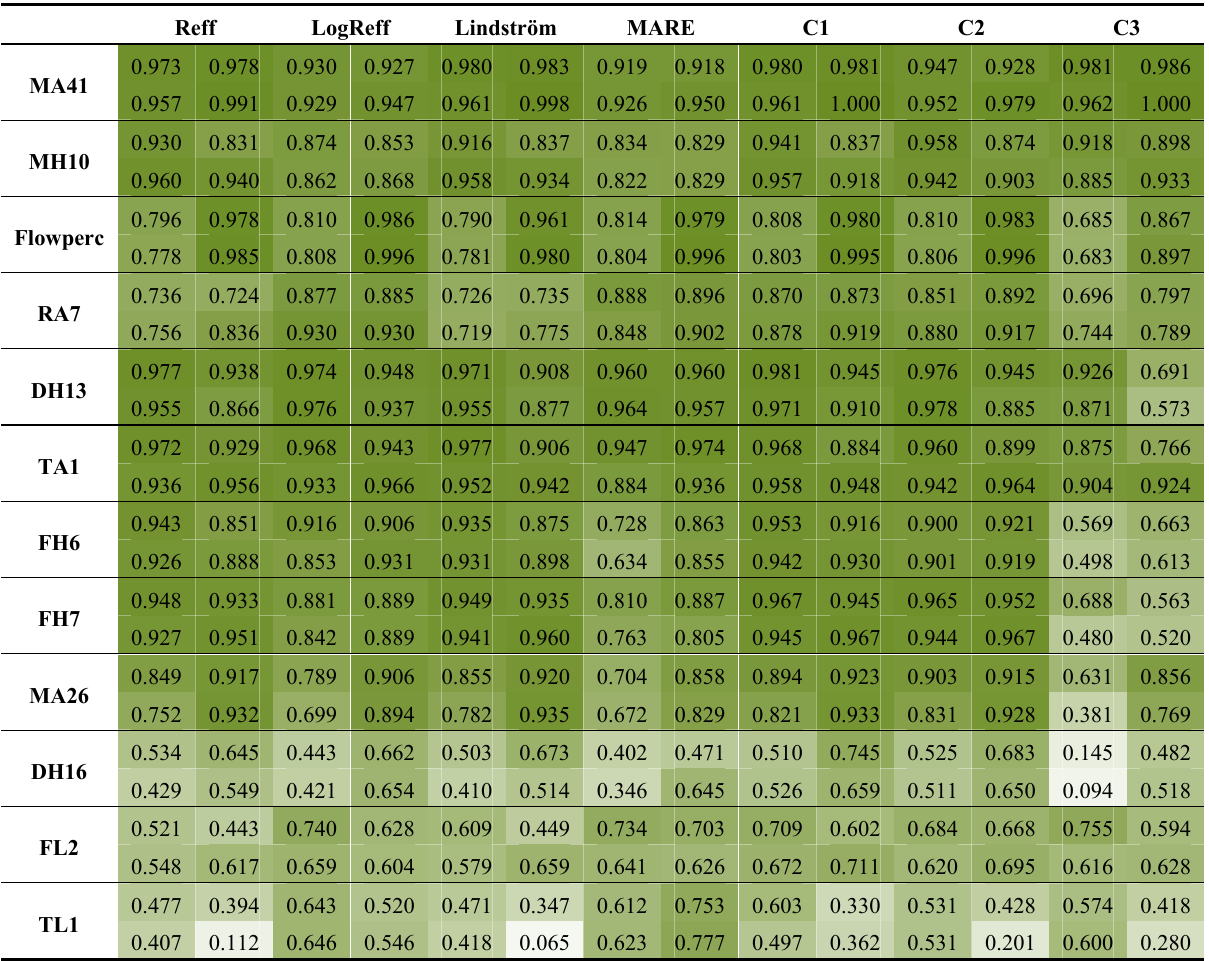
Table 6. Spearman rank correlation coefficients between objective functions (horizontal) and streamflow characteristics (vertical) based on observed respective simulated streamflow (for each group of four values: upper − left = calibration period 1 (Cal1), upper − right = validation period 2 (Val2), lower − left = validation period 1 (Val1), lower − right = calibration period 2 (Cal2)). Colors are ranging from white (for a Spearman rank correlation of 0) to dark green (for a Spearman rank correlation of 1).